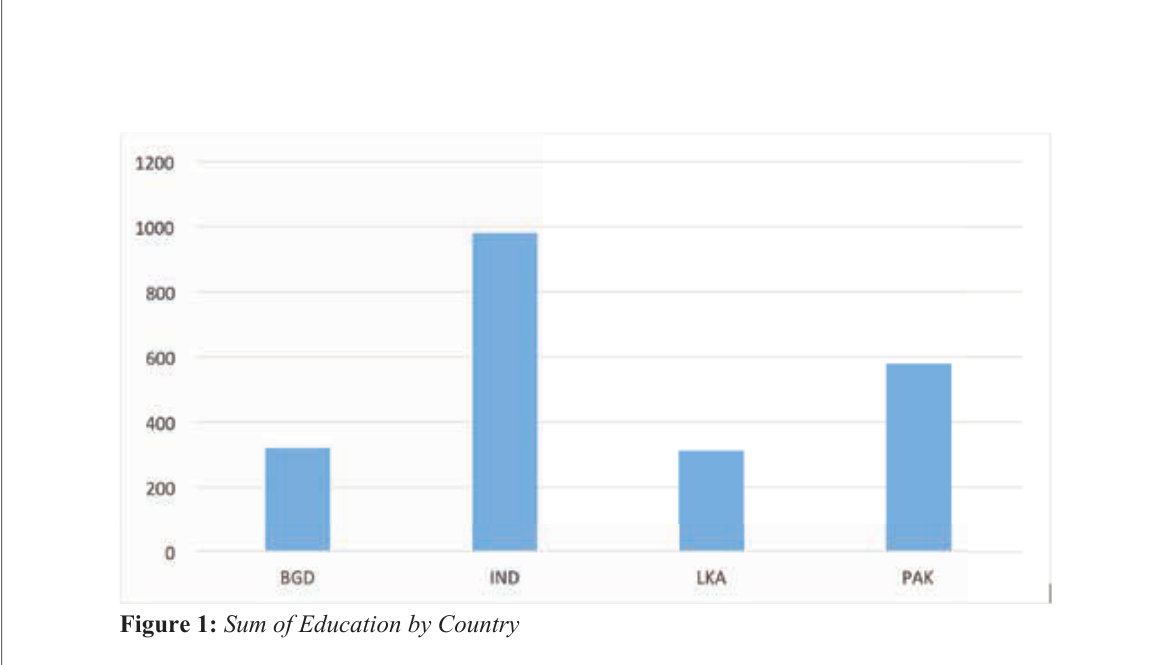
Figure 1: Sum of Education by Country